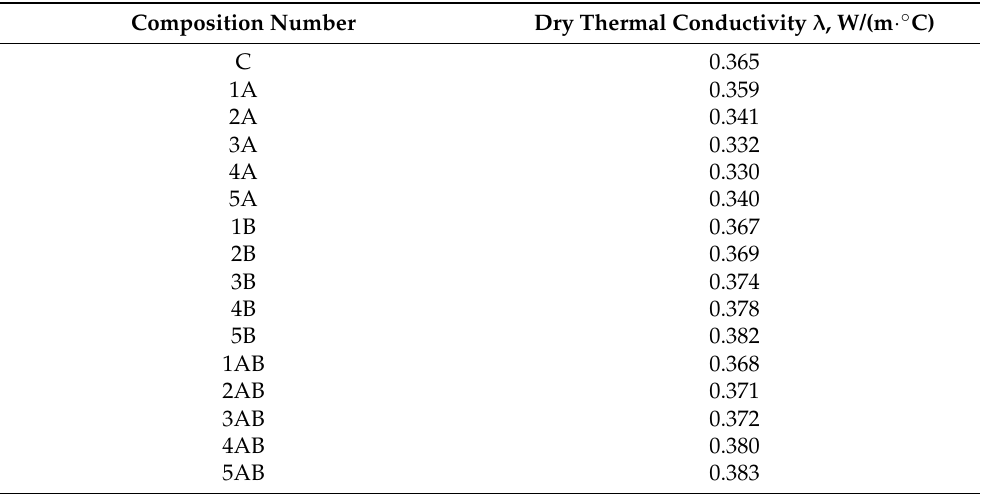
Table 12. Results of determining the thermal conductivity of samples of non-autoclaved aerated concrete. Composition